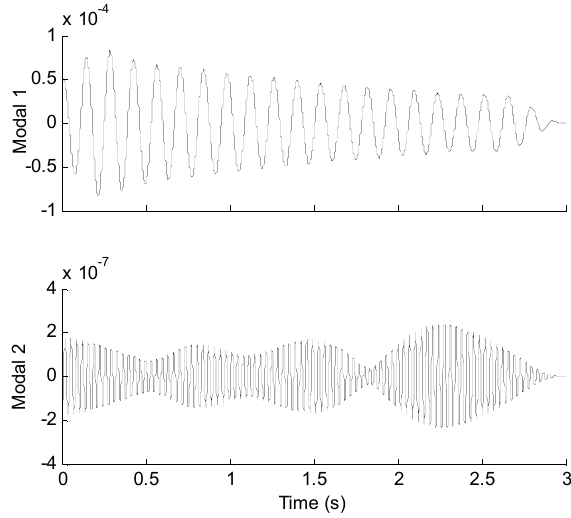
Figure 9. Modal responses of the strain measurement data obtained by EMD method with intermittency criteria.